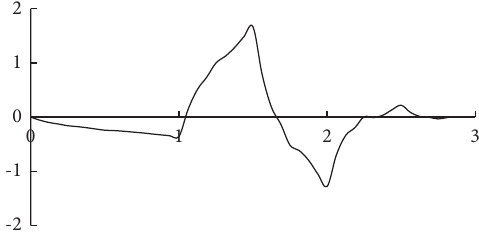
Figure 2: Schematic diagram of ‘db4’